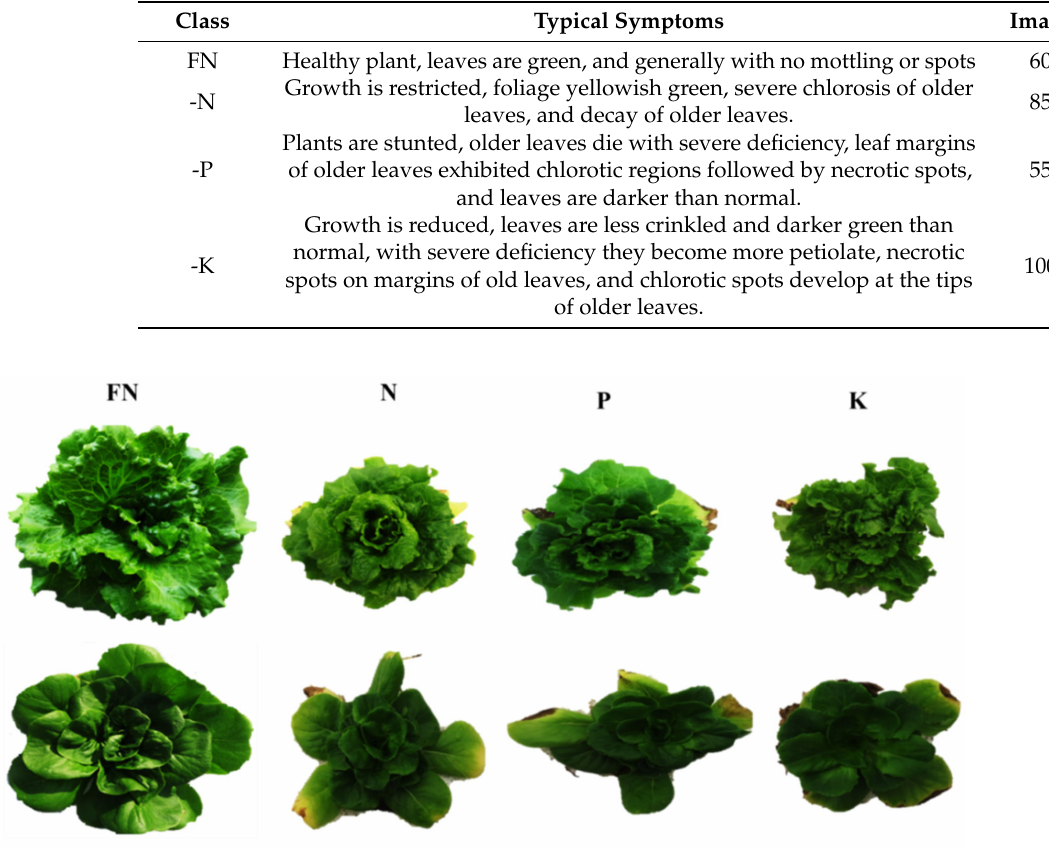
Figure 3. Visual appearance of fully nutritious (FN) lettuce plants and general symptoms of and NPK deficiencies in Romaine and Flandria